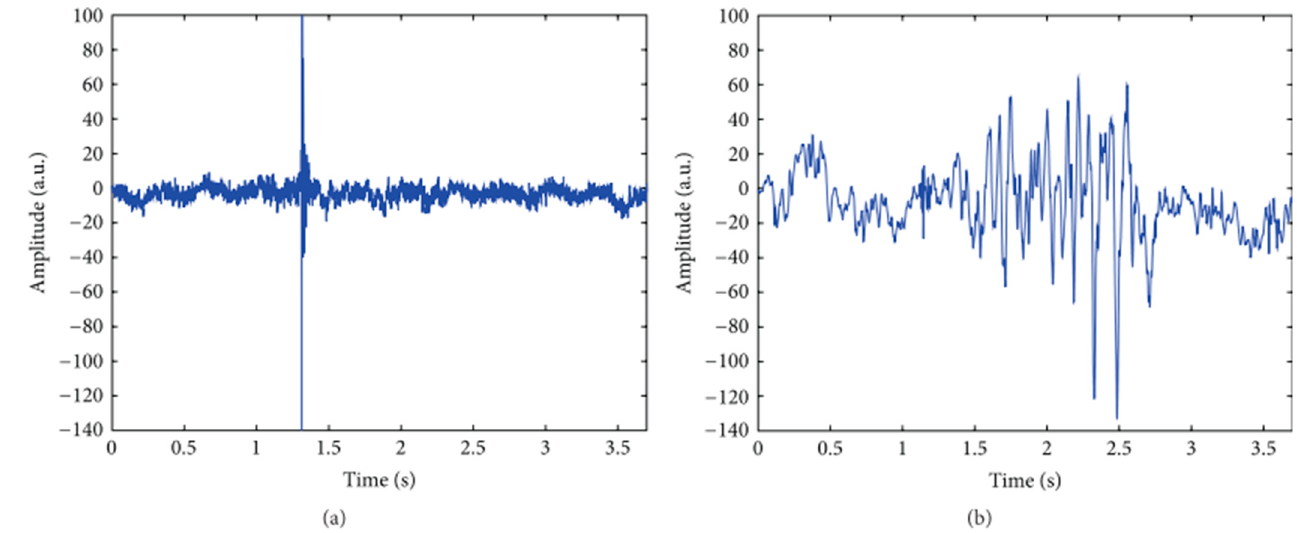
Figure 4. Example of a waveform obtained by an accelerometer on a healthy knee in ( a ) and from a knee with pathology in ( b ) (from [20]). The short-time burst in ( a ) is often referred to as a “patellar click”.